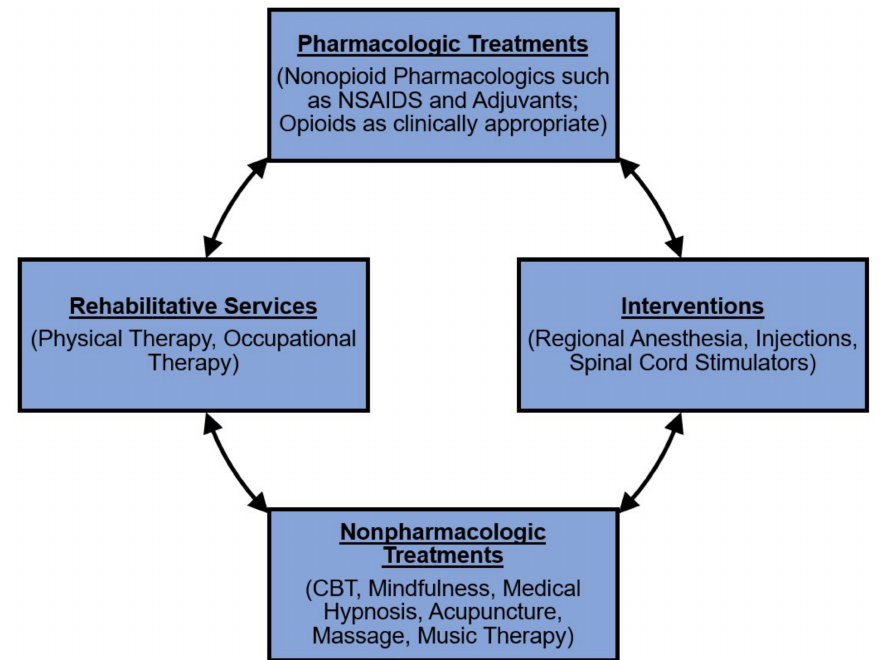
Figure 1. Multidisciplinary pain management treatment: key components in acute and chronic pain management. This figure displays the key treatment components in multidisciplinary treatment for both acute and chronic pain. In the acute setting, in addition to reduction of pain, the